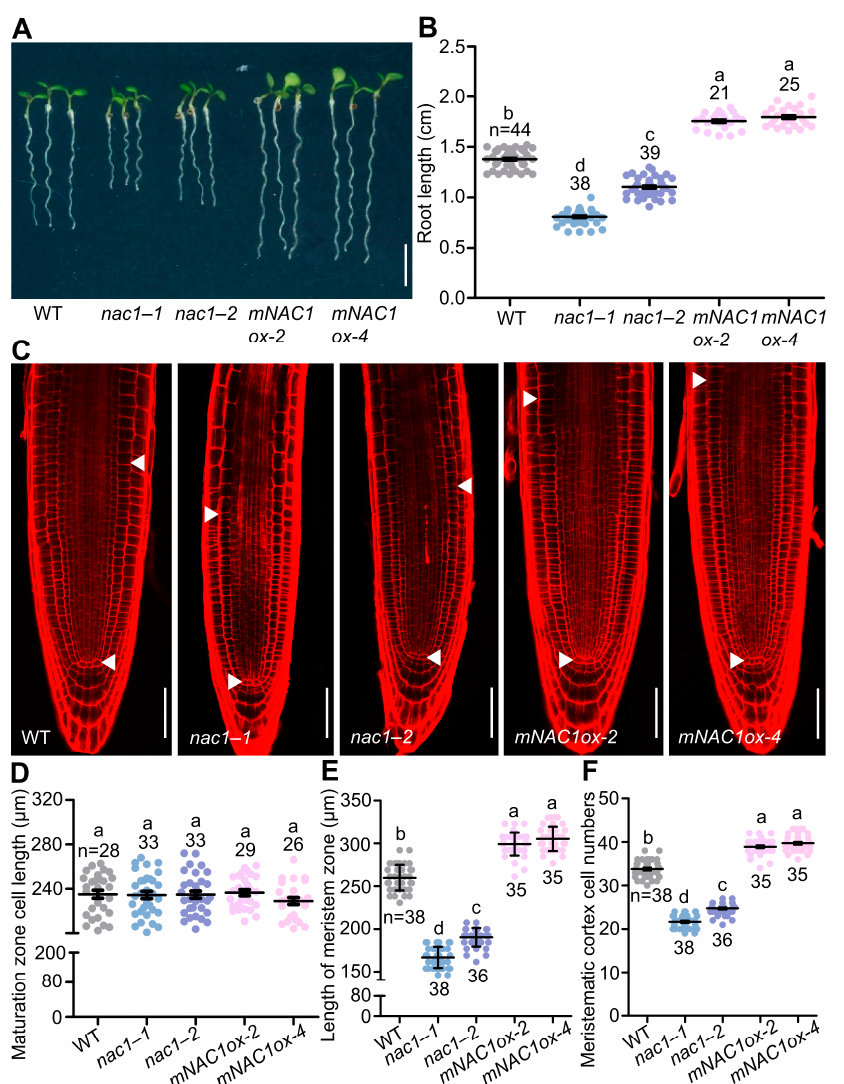
Figure 1. NAC1 is required for primary root growth. ( A ) The root growth phenotypes of WT, nac1 – 1 , nac1 – 2 , and two independent overexpression transgenic lines of mNAC1ox-2 or mNAC1ox-4 grown on 1/2 MS medium. The seedlings were photographed at 5 days post-germination (dpg). Scale bar represents 0.5 cm. ( B ) Measurements of primary root length of WT, nac1–1 , nac1–2 , and two independent overexpression transgenic lines as shown in ( A ). ( C ) Confocal images of root tips of WT, nac1–1 , nac1–2 , and two independent overexpression transgenic lines as shown in ( A ). The seedlings were used at 5 dpg for imaging. White arrows indicate the boundary between root meristem and transition zones. White arrows below indicate the quiescent center (QC). Scale bars represent 50 μ m. ( D ) Root cortical cell length in the maturation zone of 5 dpg seedlings as shown in ( C ). ( E ) Length of meristem zone of 5 dpg seedlings as shown in ( C ). ( F ) Cell numbers in the proliferation domain of 5 dpg seedlings as shown in ( C ). Data information: in ( B , D – F ), data represent mean ± SD, n denotes the total number of scored samples. Individual values (black dots) are shown. Different lowercase letters indicate significant differences by one-way ANOVA followed by Tukey’s multiple comparison test ( p < 0.05).